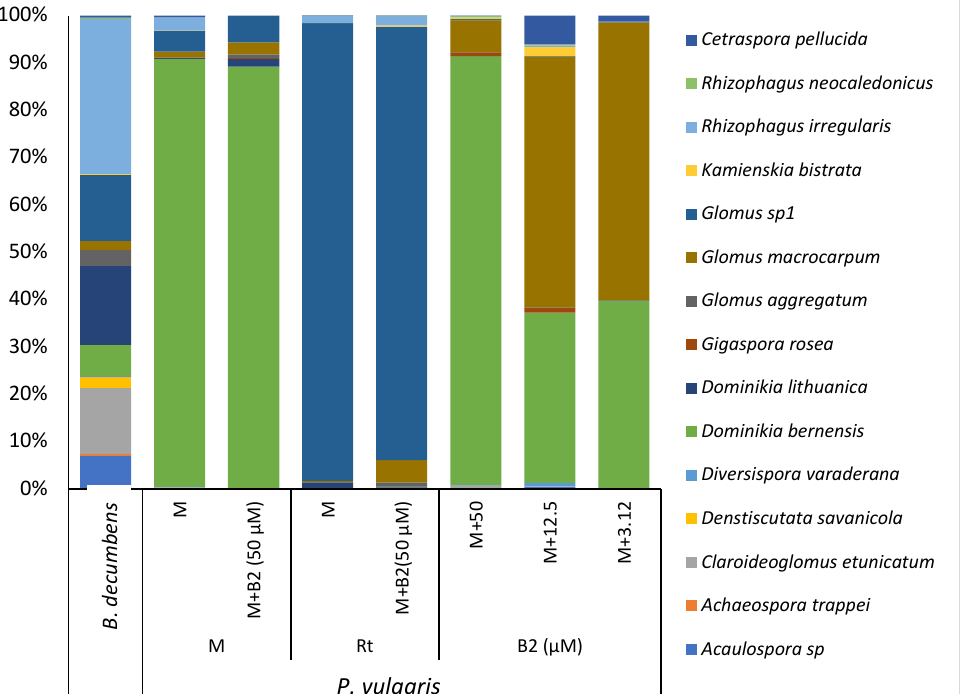
Figure 4. Arbuscular mycorrhizal fungi (AMF) composition and relative abundances in Phaseolus vulgaris root determined by a sequencing analysis of mycorrhizal SSU rRNA amplicons. Left, original inoculum obtained from Brachiaria decumbens Stapf (Poaceae). M, arbuscular mycorrhizal fungi inoculation; B2, irrigated with 50 µM riboflavin n; Rt, Rhizobium tropici CIAT 899 inoculation; C, control without inoculation.